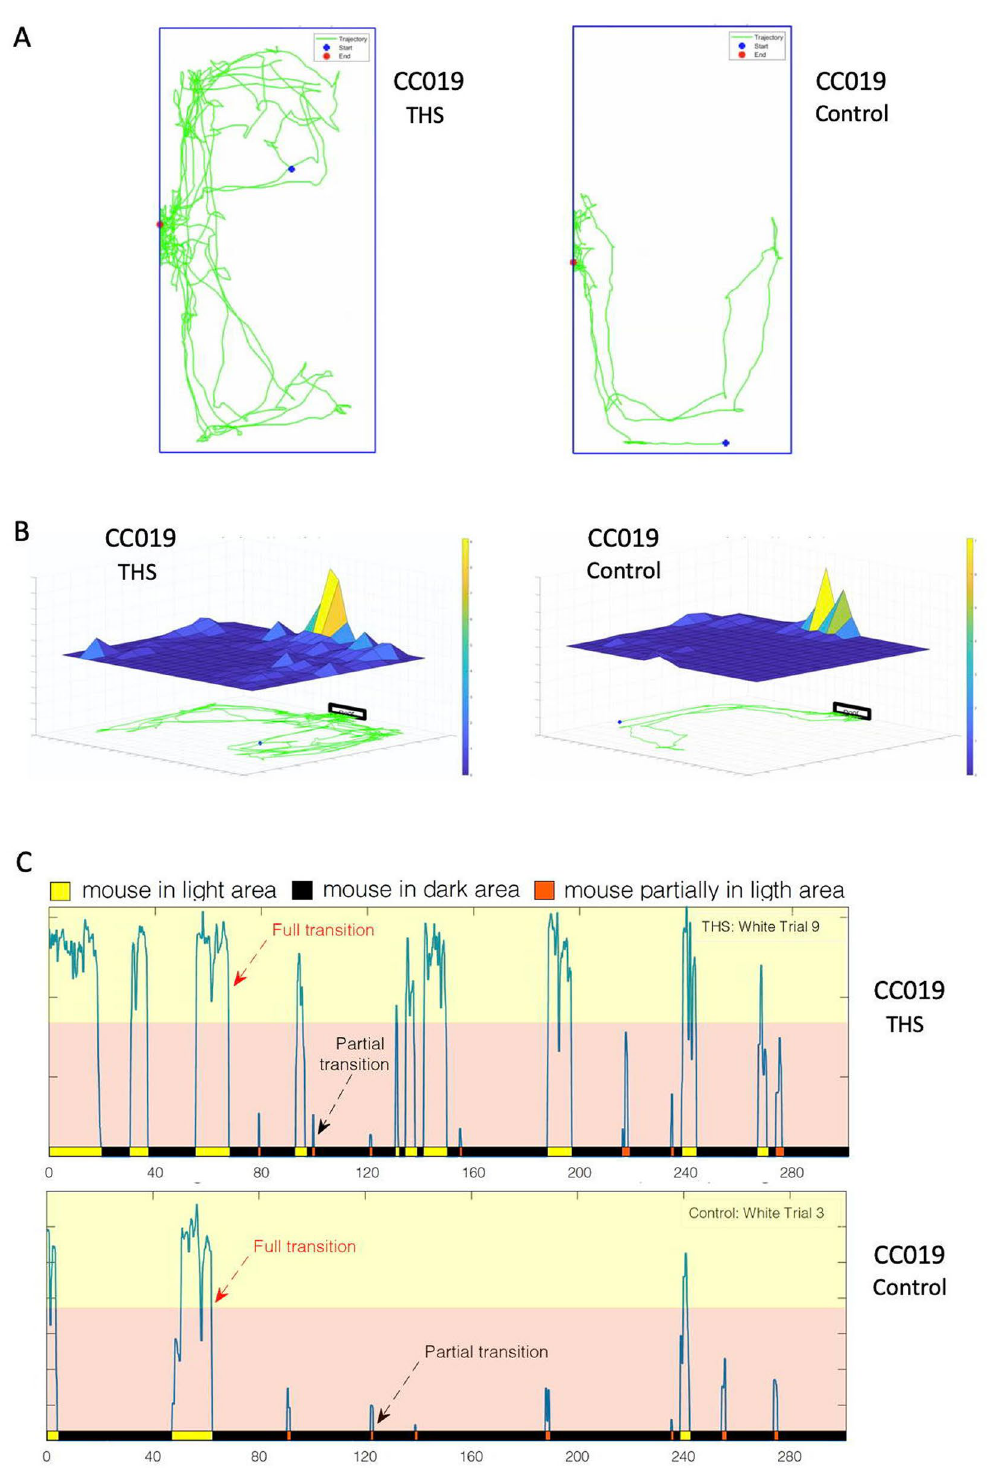
Figure 1. Anxiety test and multivariate phenotyping system. ( A ) Mouse video tracking showing the 5-min trajectory (green line) of a THS exposed (left) and control (right) CC019 mouse in the light compartment of the light–dark box. ( B ) Heatmaps of the THS exposed CC019 mouse (left) or control CC019 mouse (right), showing the cumulative time spent at each location in the light box. ( C ) Representative profile of a THS (top) and control (bottom) exposed CC019 mouse in the light–dark box for the 300 s test duration. Transitions between the light and dark compartments were determined by measuring the relative body area in the light area. The bar at the bottom of the profile indicates the presence of the mouse in the dark area (black), the light area (yellow) or in between the light and dark boxes